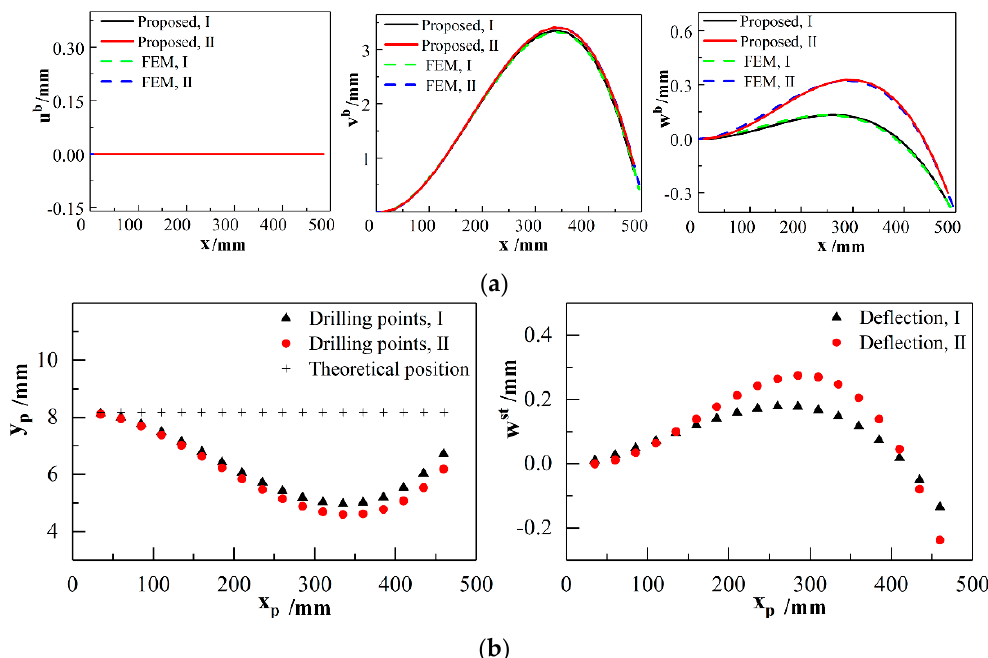
Figure 5. Deformation of stringers and presented deflections of points to be joined. ( a ) Deformation of beam I and II along the centroid locus of cross-section; ( b ) positions and deflection of drilling points on the stringers I and II.